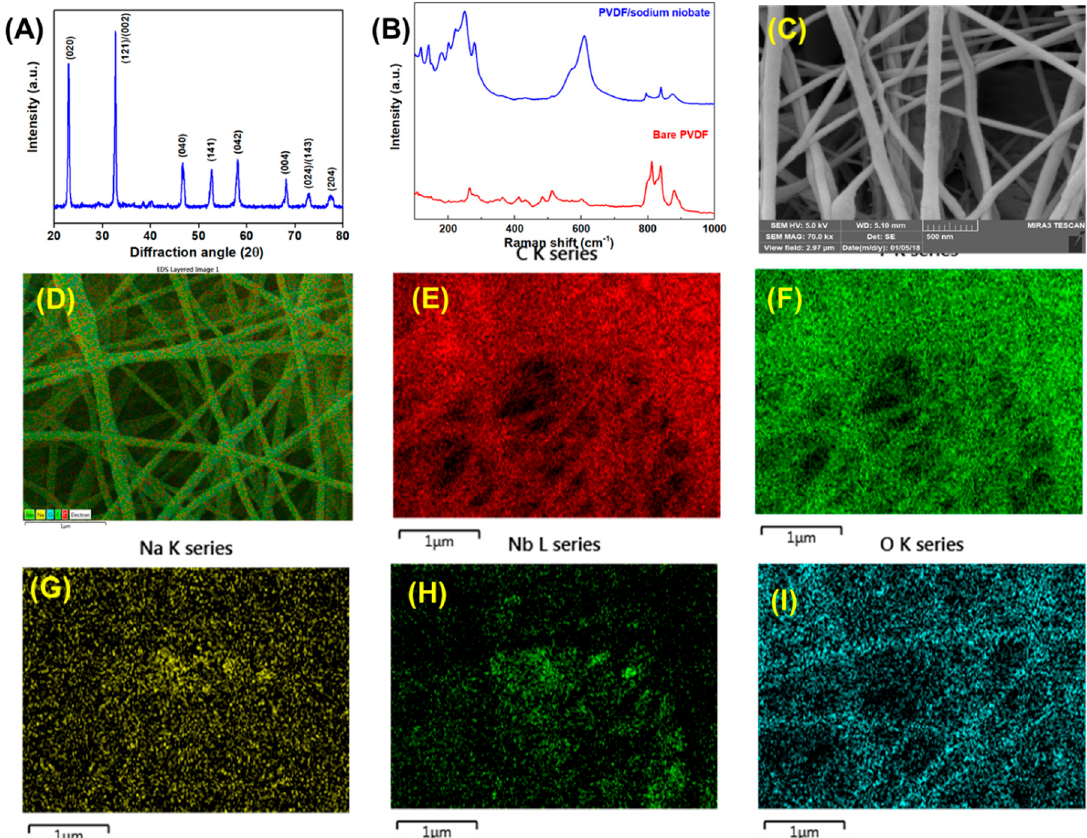
Figure 1. ( A ) X-ray diffraction pattern of the prepared sodium niobate. ( B ) Laser Raman spectra of the bare polyvinylidene fluoride (PVDF) and electrospun PVDF/sodium niobate nanofibrous mat. Surface morphology of the PVDF/sodium niobate nanofibers ( C ) high-resolution micrographs. Elemental mapping analysis of the PVDF/sodium niobate nanofibers ( D ) overlay field-emission scanning electron micrograph (FE-SEM) of PVDF/sodium niobate nanofibers, ( E ) elemental mapping showing the distribution of C element, ( F ) elemental mapping showing the distribution of F element, ( G ) elemental mapping showing the distribution of Na element, ( H ) elemental mapping showing the distribution of Nb element and ( I ) elemental mapping showing the distribution of O element present in PVDF/sodium niobate nanofibers.